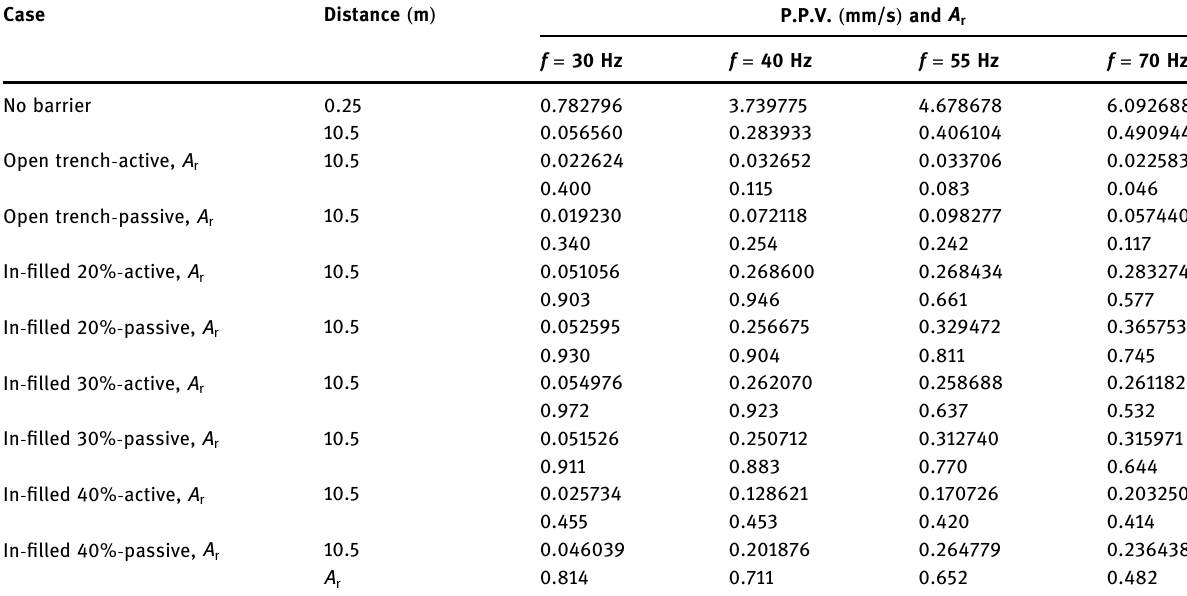
Table 14: Peak particle velocities and amplitude reduction ratios at the targeted point Case Distance ( m ) P.P.V. ( mm/s ) and A r f 30 Hz = f 40 Hz = f 55 Hz = No